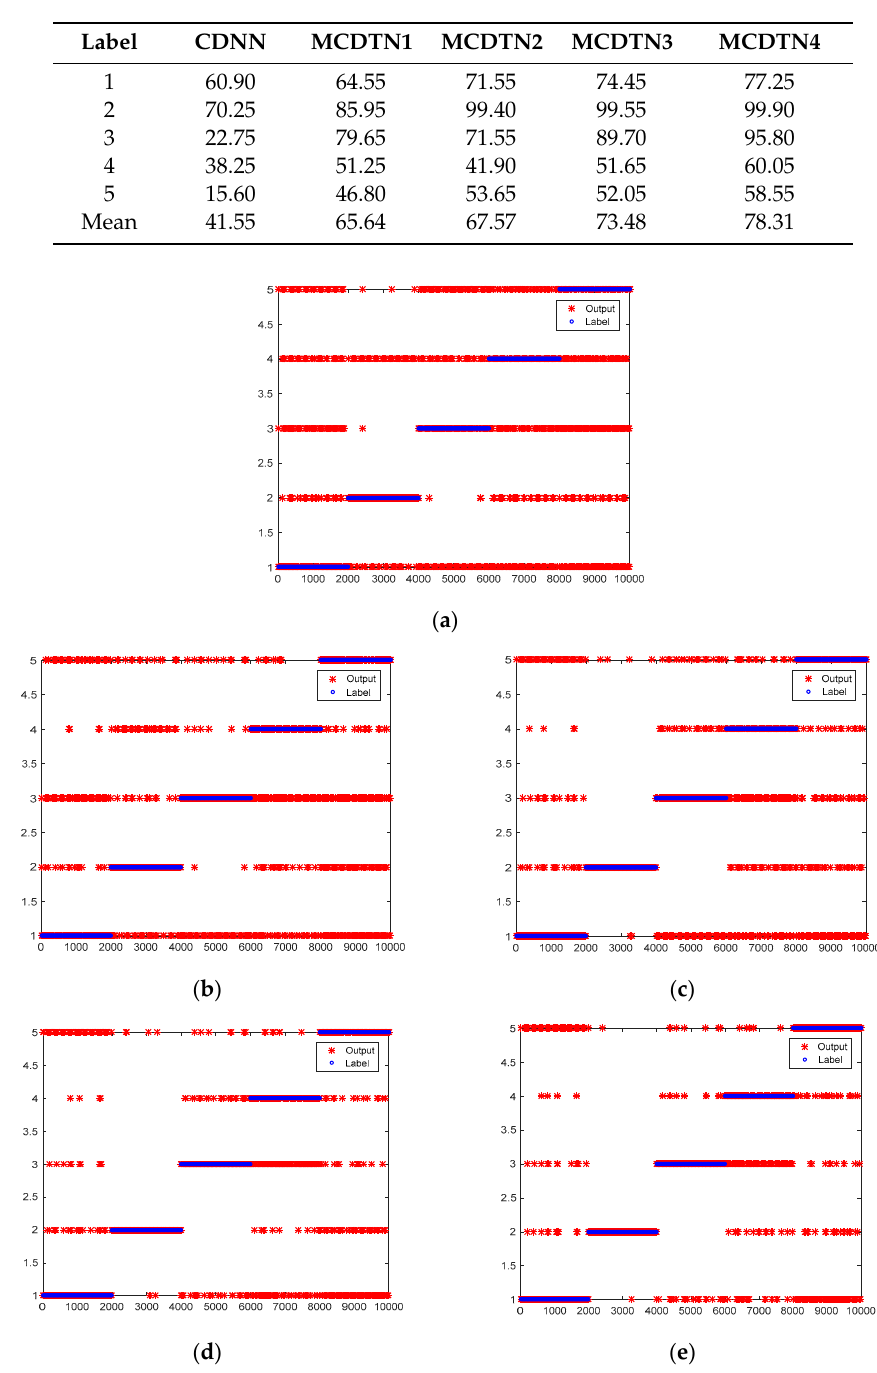
Table 7. The accuracy of DNN and DTNs when the ratio of incomplete data to structurally-complete data is 60:1.